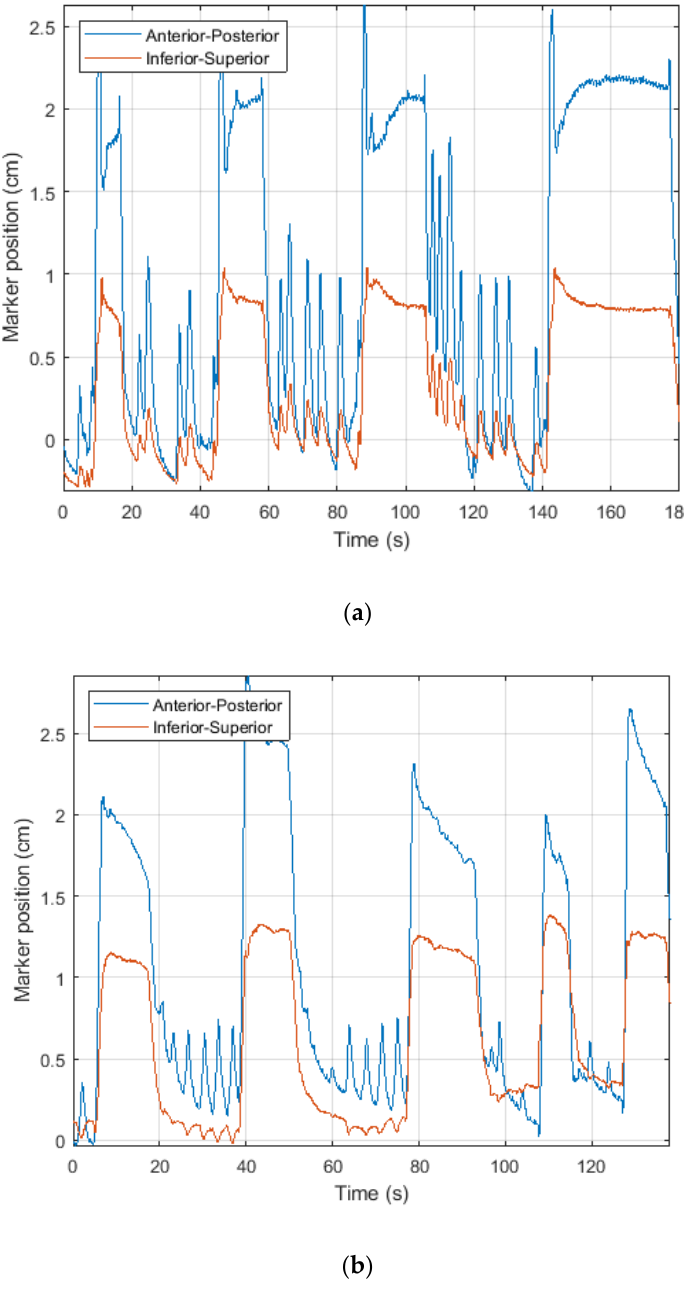
Figure 3. ( a , b ): examples of respiratory tracks acquired for selecting DIBH threshold. ( a ) is an ex- ample of a track from a patient from the group considered eligible for DIBH due to higher decrease of maximum dose to the LAD from FB, while ( b ) is from a patient in the group with lower LAD dose